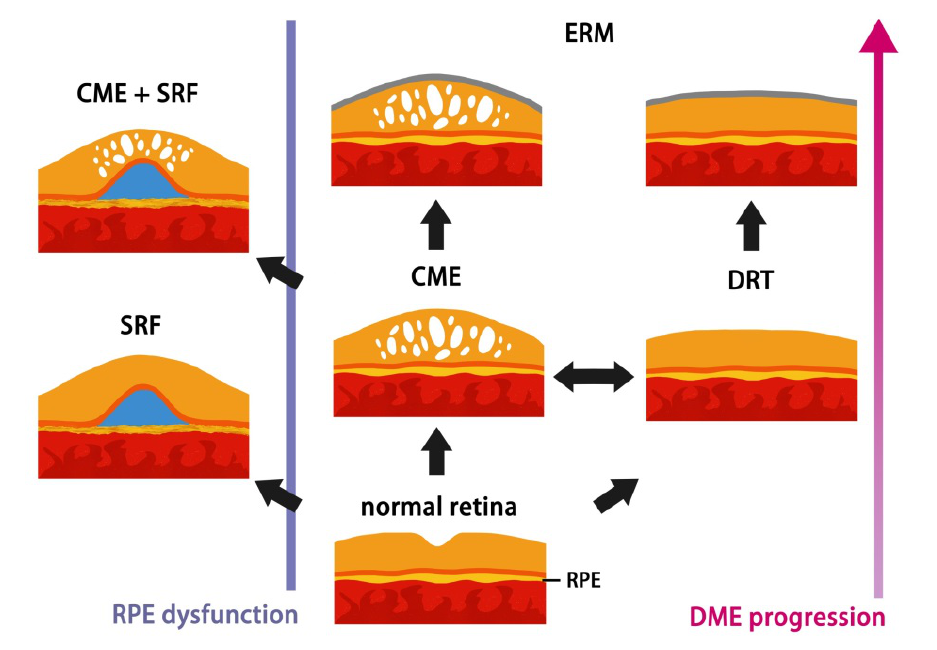
Figure 2. Schematic diagram of hypothesis of DME morphological procession changes on OCT.